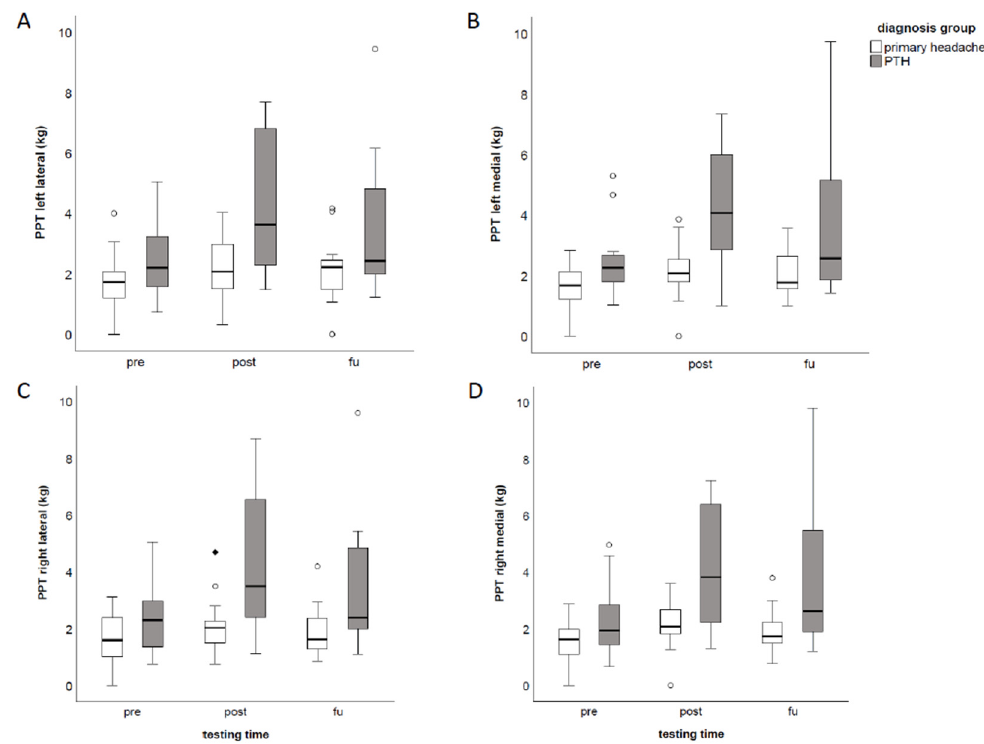
Figure 2. Comparison of PPT changes across time between the primary headache group (white) and PTH group (grey). ( A ) Comparison of PPT above left lateral reference point, ( B ) Comparison of PPT above left medial reference point, ( C ) Comparison of PPT above right lateral reference point, ( D ) Comparison of PPT above right medial reference point. Abbreviations: PPT: pressure pain threshold, PTH: post-traumatic headache, pre: before the first rNMS session, post: before the last rNMS session, FU: follow-up.